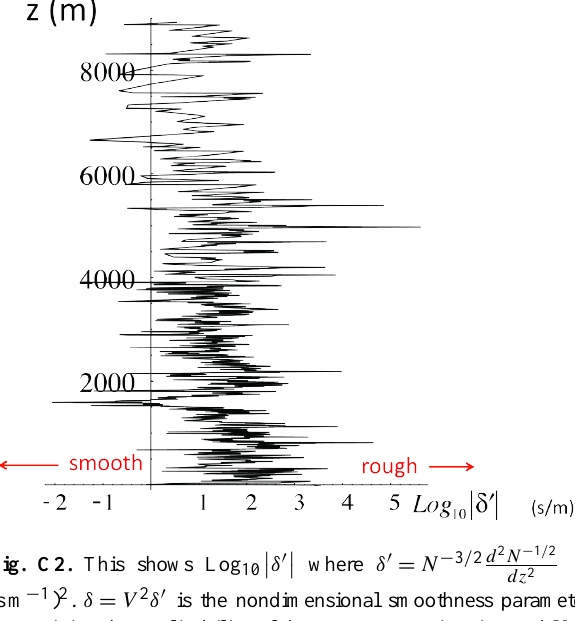
(cid:12) 0 = N − 3 / 2 d 2 N − 1 / 2 0 (cid:12) Fig. C2. This shows Log 10 in (cid:12) where δ (cid:12) δ dz 2 (sm − 1 ) 2 . δ = V 2 δ 0 is the nondimensional smoothness parameter determining the applicability of the WKB approximation and V is the wave speed (assumed constant). For the WKB approximation to be valid, we require δ (cid:28) 1.